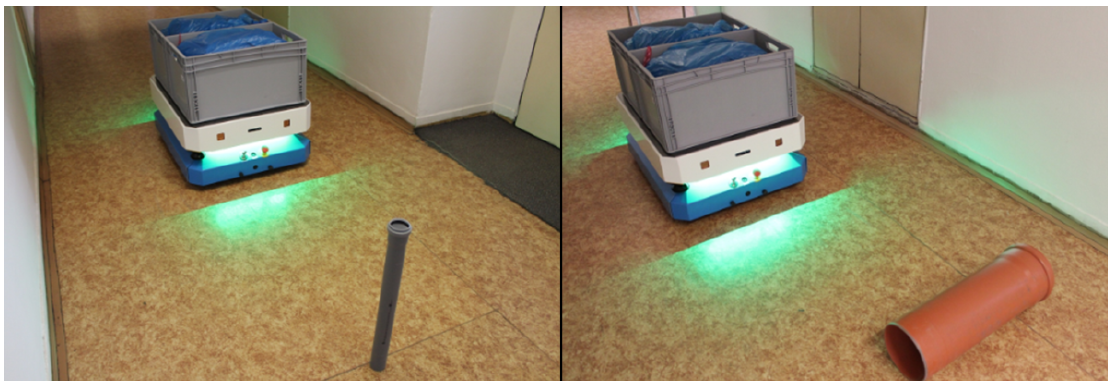
Figure 7. Experimental verification of the braking distance value.